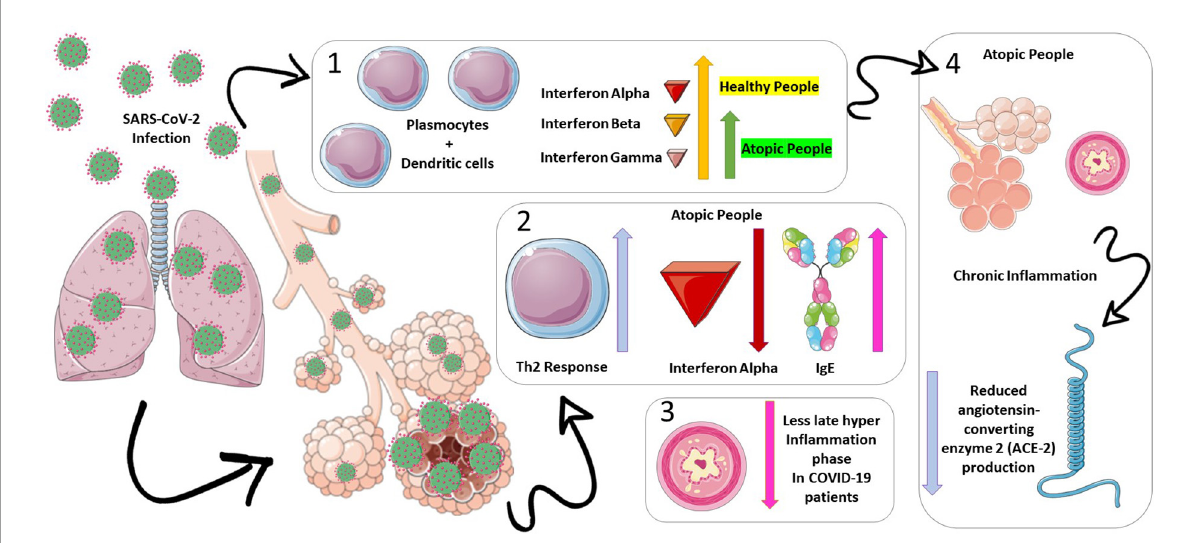
FIGURE1 Physiopathology hypothesis on asthma’s protective mechanisms for death on coronavirus disease (COVID-19) infections. Atopic patients have a low production of interferons alpha (represented in red), beta (represented in orange), and gamma (represented in purple), which constitutes an inadequate antiviral defense (section 1 of the figure). In this scenario, lower interferon productions (mainly alpha) lead to a predominance of the Th2 response over the Th1 in patients with asthma (section 2 of the figure). This predominance may be protective, as it can downregulate the late phase of hyperinflammation in patients with asthma, which is a hallmark of severe respiratory viral infections (section 3 of the figure). Moreover, the inflammatory environment of the bronchoalveolar system in patients with asthma could result in a decrease in the expression